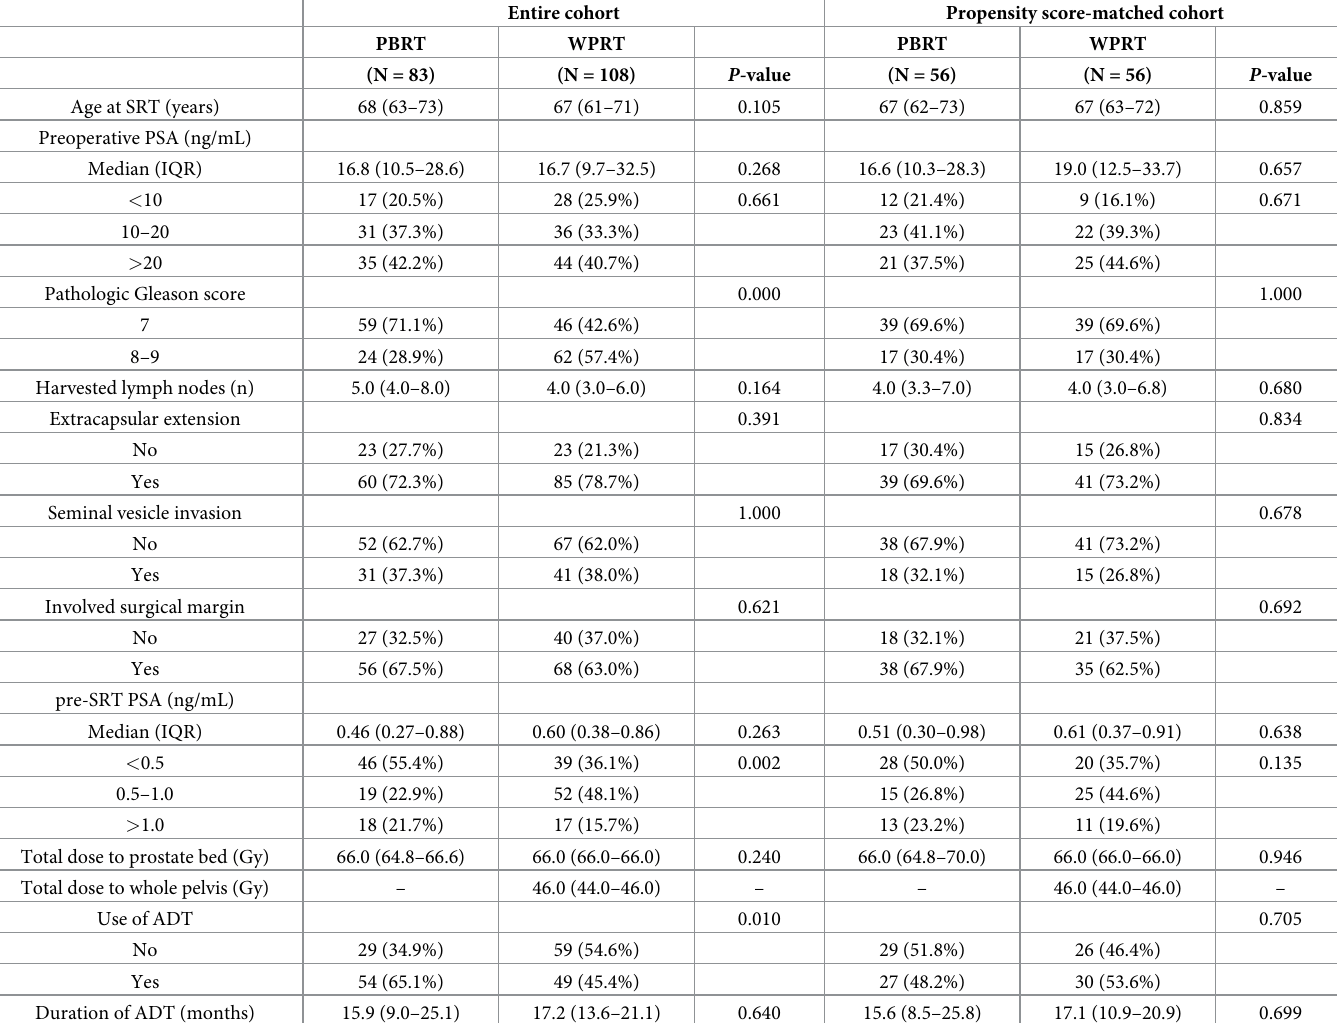
Table 1. Baseline variables before and after propensity score matching, stratified by radiation field (PBRT vs.